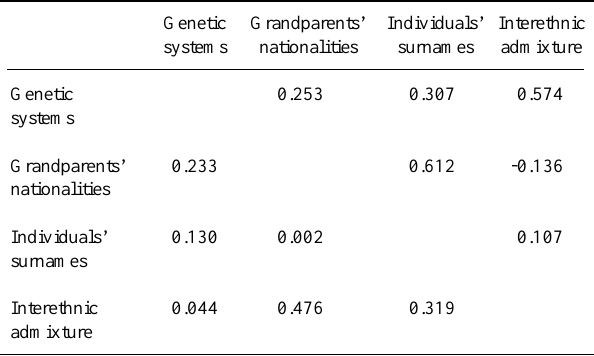
Table VI - Agreement between distance matrices based on four sets of data obtained in Rio Grande do Sul and Santa Catarina. Upper triangle: Mantel’s (1967) coefficients; lower triangle: P